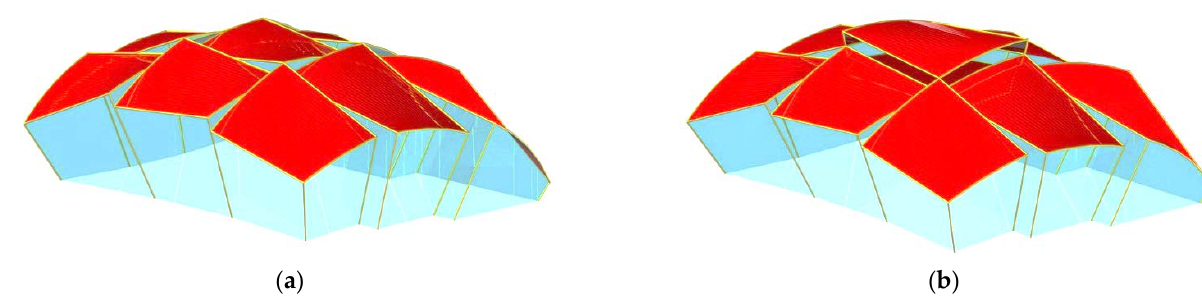
Figure 6. Two geometric models of building free forms roofed with complex corrugated shell sheeting structures with: ( a ) the rotated directrices of the central shell unit; ( b ) the translated directrices of the central shell unit.